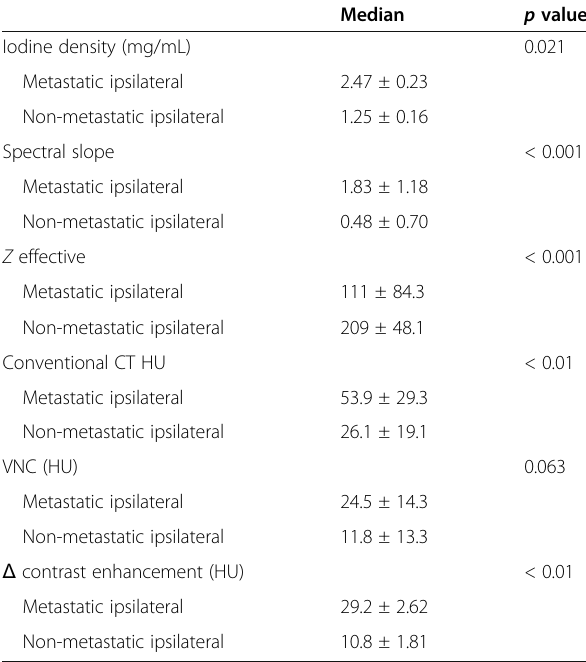
Table 2 Quantitative dual-layer spectral CT parameters from metastatic and non-metastatic ipsilateral axillary lymph nodes